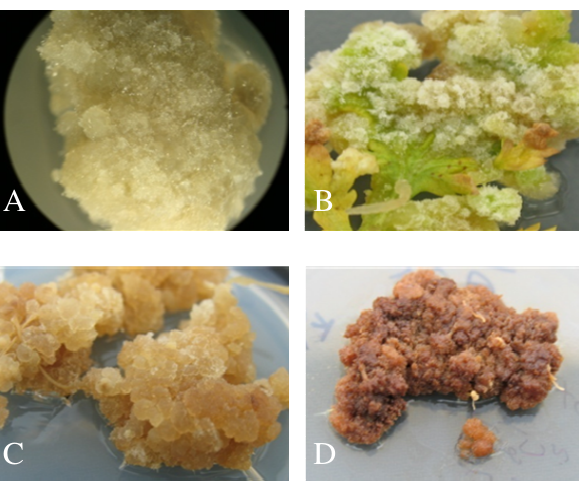
Fig. 2. Different colors of calli initiated in the MS medium containing different concentrations of NAA and BAP and carbon sources; A: white calli (leaf explants, 0.5 mg/L NAA + 0.5 mg/L BAP + sucrose); B: snow white calli (leaf explants, 2 mg/L NAA + 0.5 mg/L BAP +